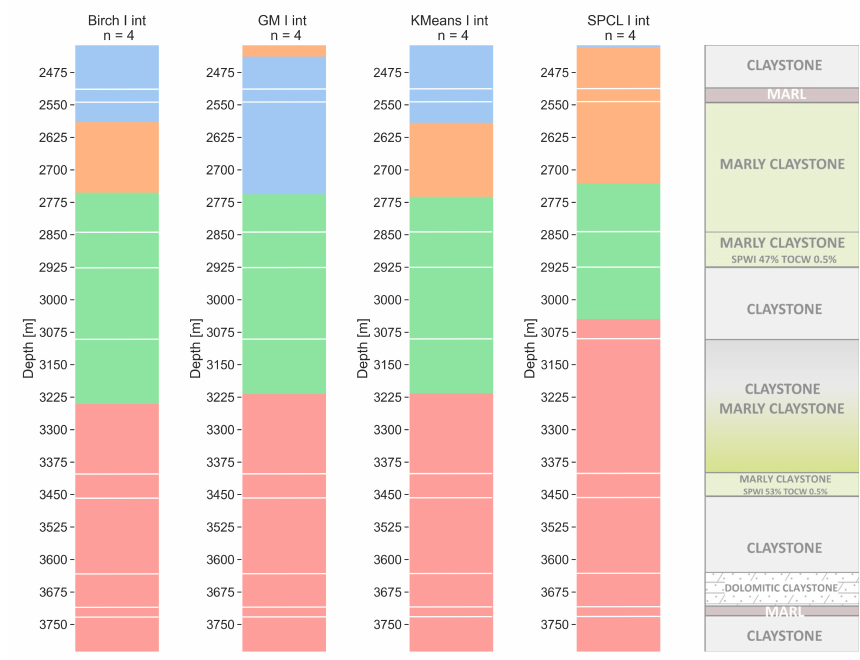
Figure 6. Walkaway VSP resolution clustering models for a number of clusters equal to 4 with lithology from well core (with lines). Clustering methods: BIRCH—balanced iterative reducing and clustering using hierarchies, GM—Gaussian mixture model, k-means, and SPCL—spectral clustering.